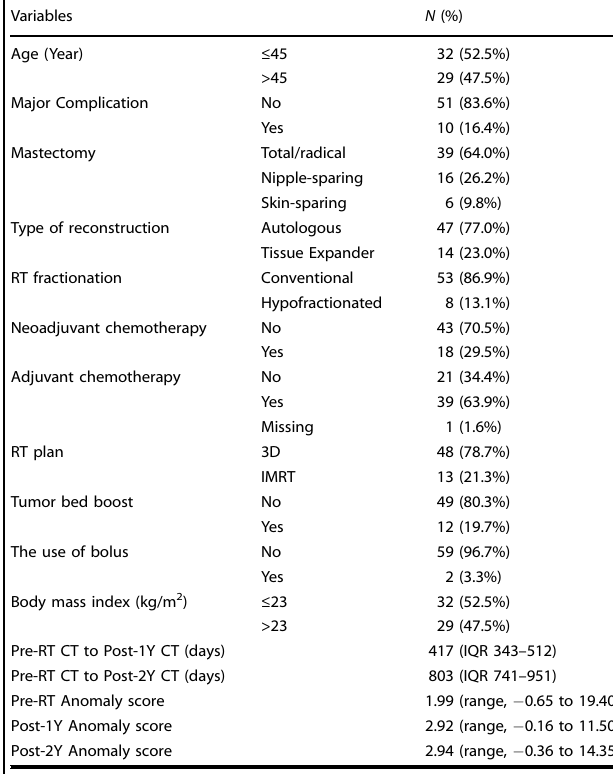
Table 1. Patient Characteristics of target dataset ( N = 61).